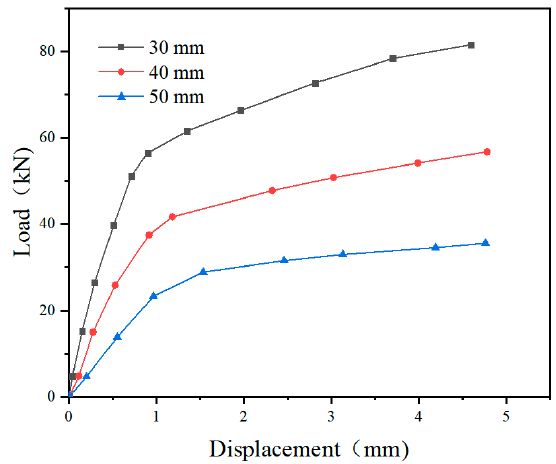
Figure 25. Load–displacement curves of FRP connectors with different insulation thicknesses.